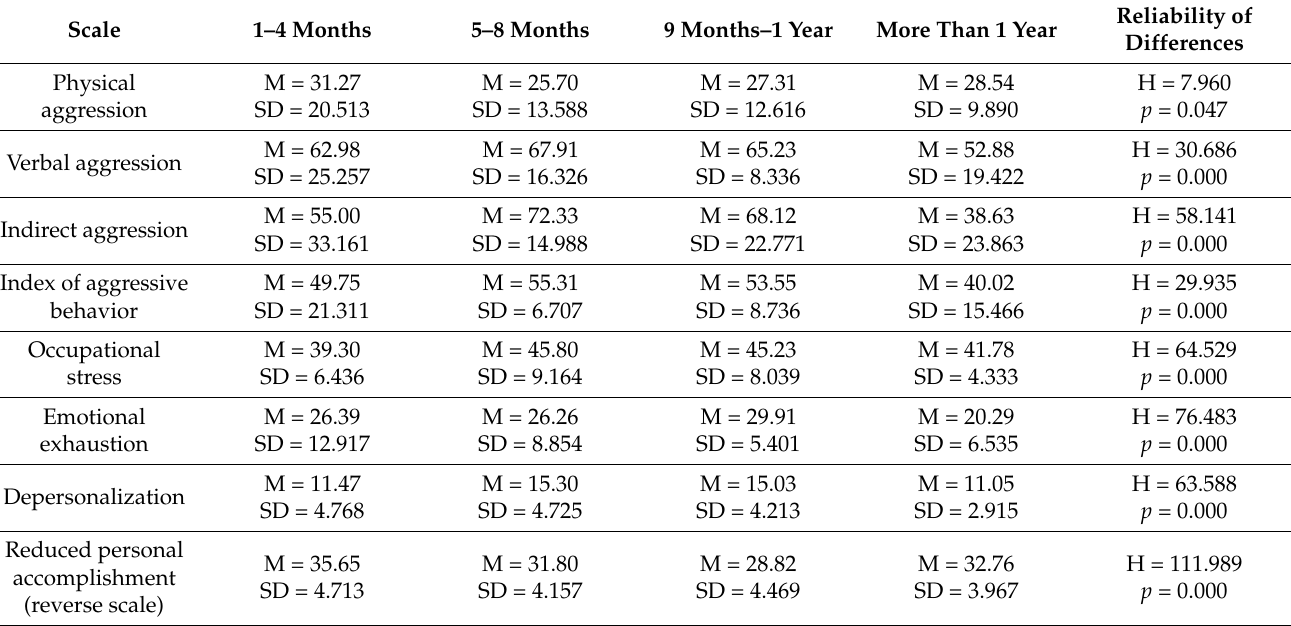
Table 15. Assessment of the average values of occupational stress level, components of occupational burnout, components of aggression, and aggressive behavior in COVID-19 ICU physicians with different employment durations. M is the mean value, SD is the standard deviation, H is the Kruskal– Wallace Criterion, and p is the significance